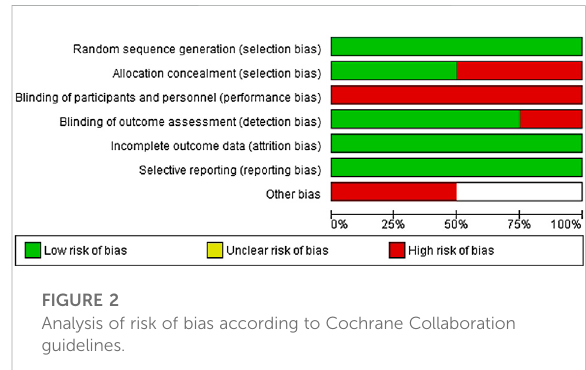
FIGURE 2 Analysis of risk of bias according to Cochrane Collaboration